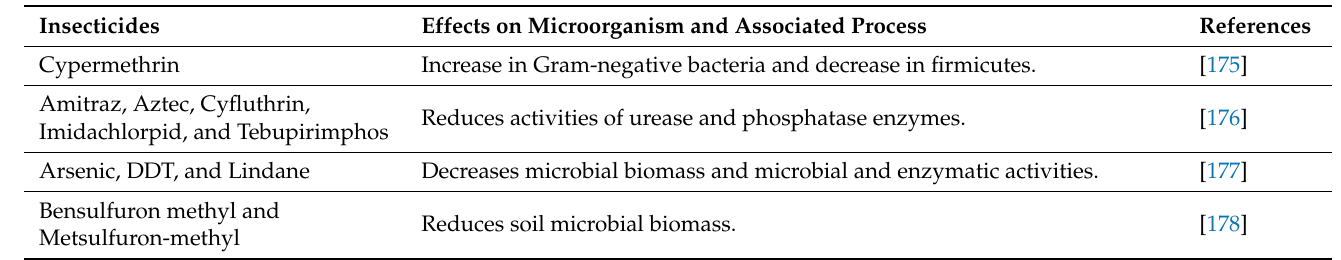
Table 3. Different insecticides with their reported effects on soil microorganisms and biochemical